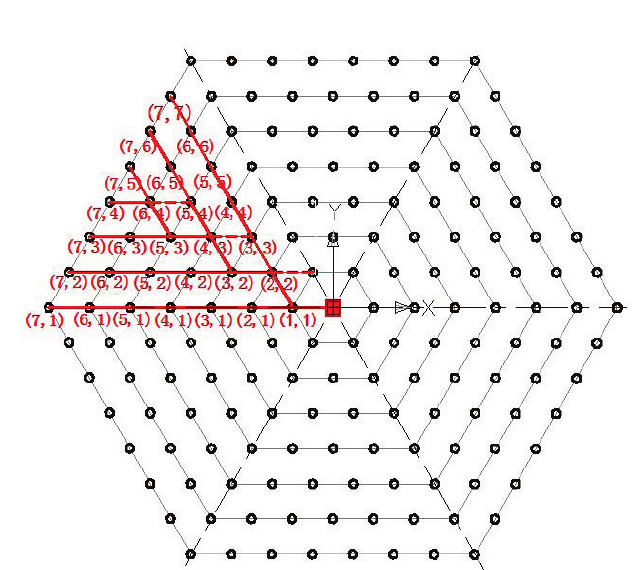
Figure 4. Data transmission